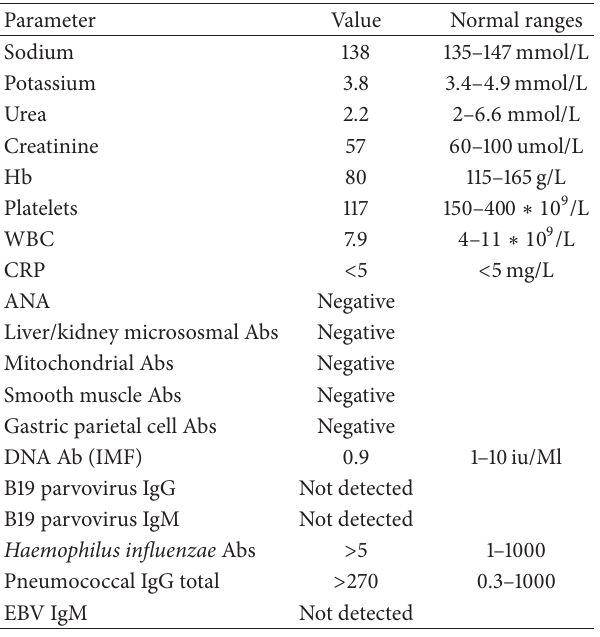
Table 1: Baseline haematological, biochemical, immunological, and microbiological investigations.